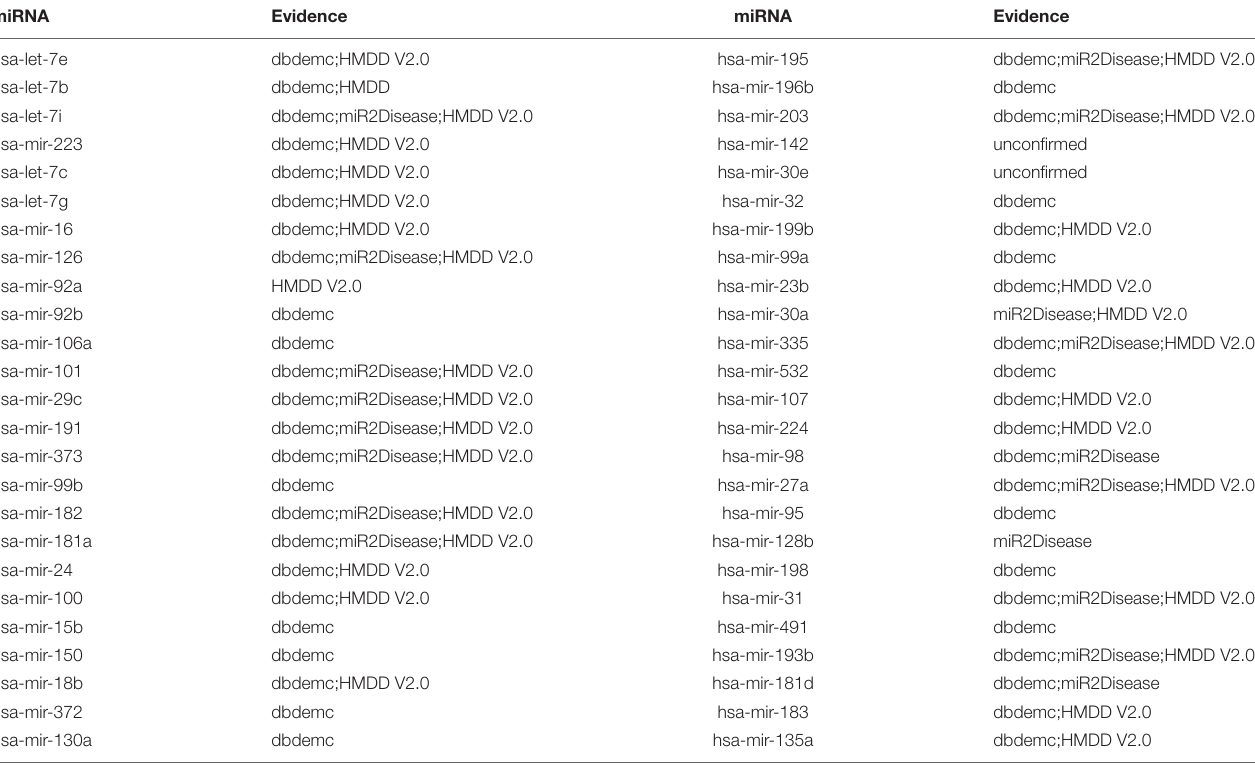
TABLE 6 | Prediction of the top 50 predicted miRNAs associated with BN based on known associations in HMDD V1.0 database. miRNA Evidence miRNA Evidence